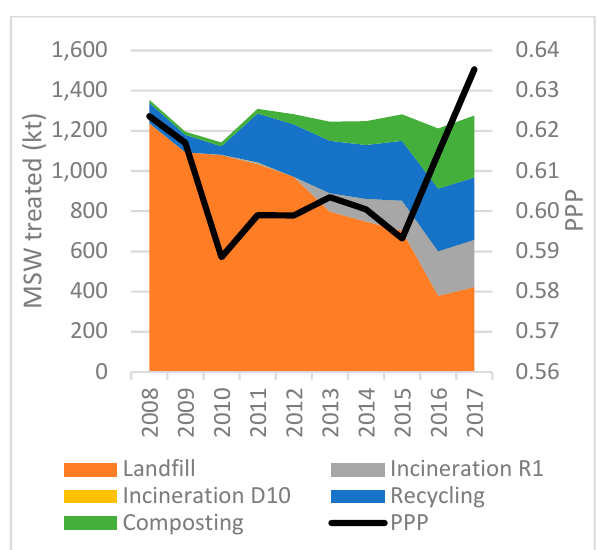
Figure 30. Waste treatment methods and PPP in Lithuania 2008–2017 (EUROSTAT 2019b, 2019c).